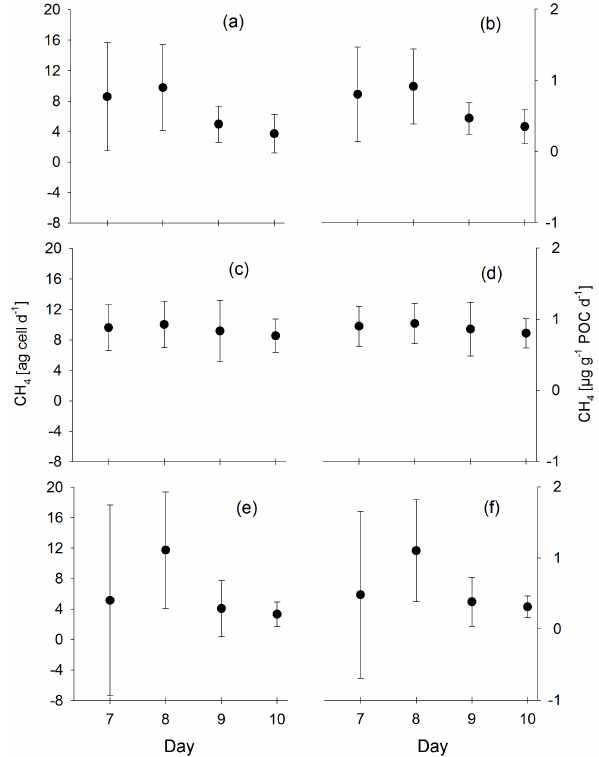
Figure 6. Daily CH 4 production of E. huxleyi for days 7 to 10 (a, c, e) on a per-cell basis and (b, d, f) relative to particulate organic car- bon (POC) separately for the treatments (a, b) E. huxleyi + 13 C-Bic ( n = 3), (c, d) E. huxleyi + 13 C-Met ( n = 3), and (e, f) E. huxleyi ( n = 2). Values are presented as means with the standard